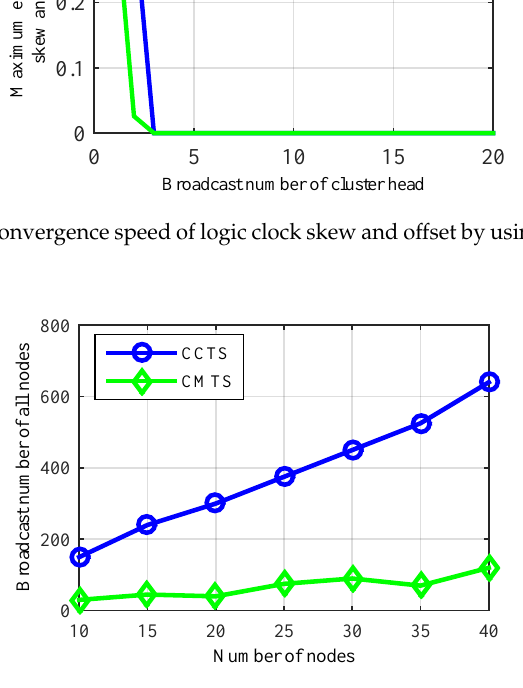
Figure 5. Comparison of Clustered Consensus Time Synchronization (CCTS) and CMTS on communication overhead in intra-cluster time